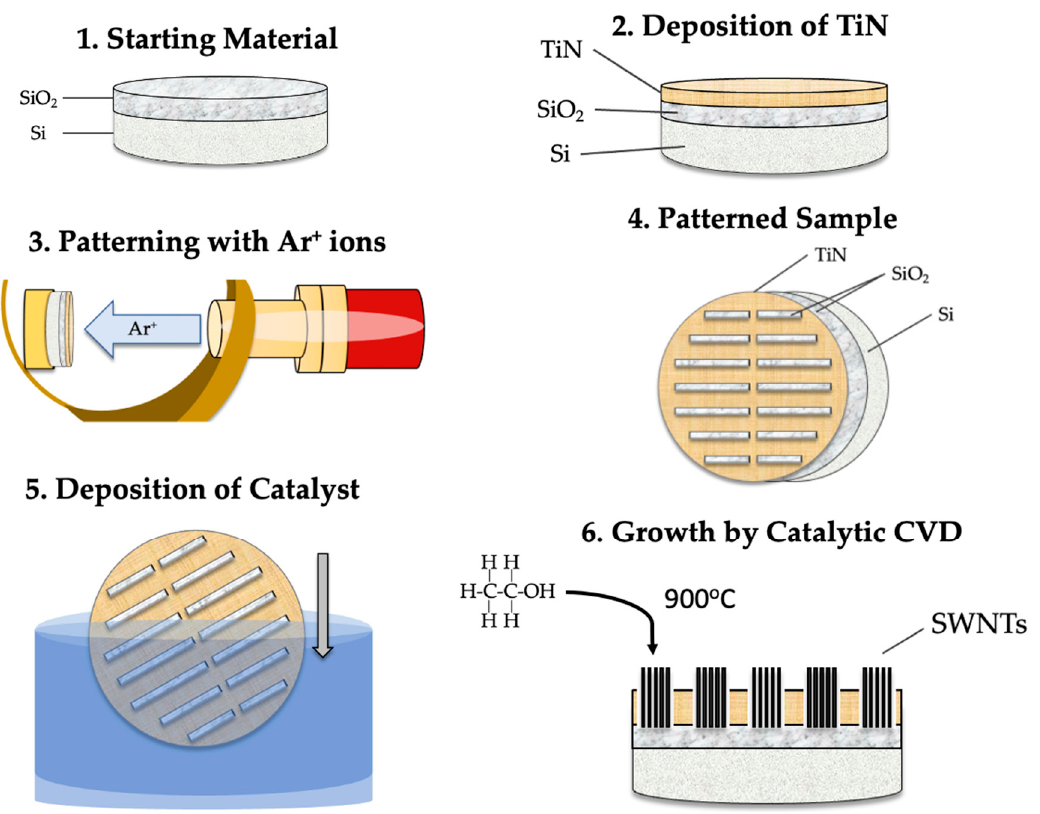
Figure 7. Schematic illustration of the substrate preparation process and the synthesis of SWCNTs: (i) obtaining thermal SiO 2 ( 1 ); (ii) TiN deposition and subsequent patterning of the substrate ( 2 – 4 ); (iii) catalyst deposition ( 5 ); and (iv) growth of SWCNTs through CCVD ( 6 ).